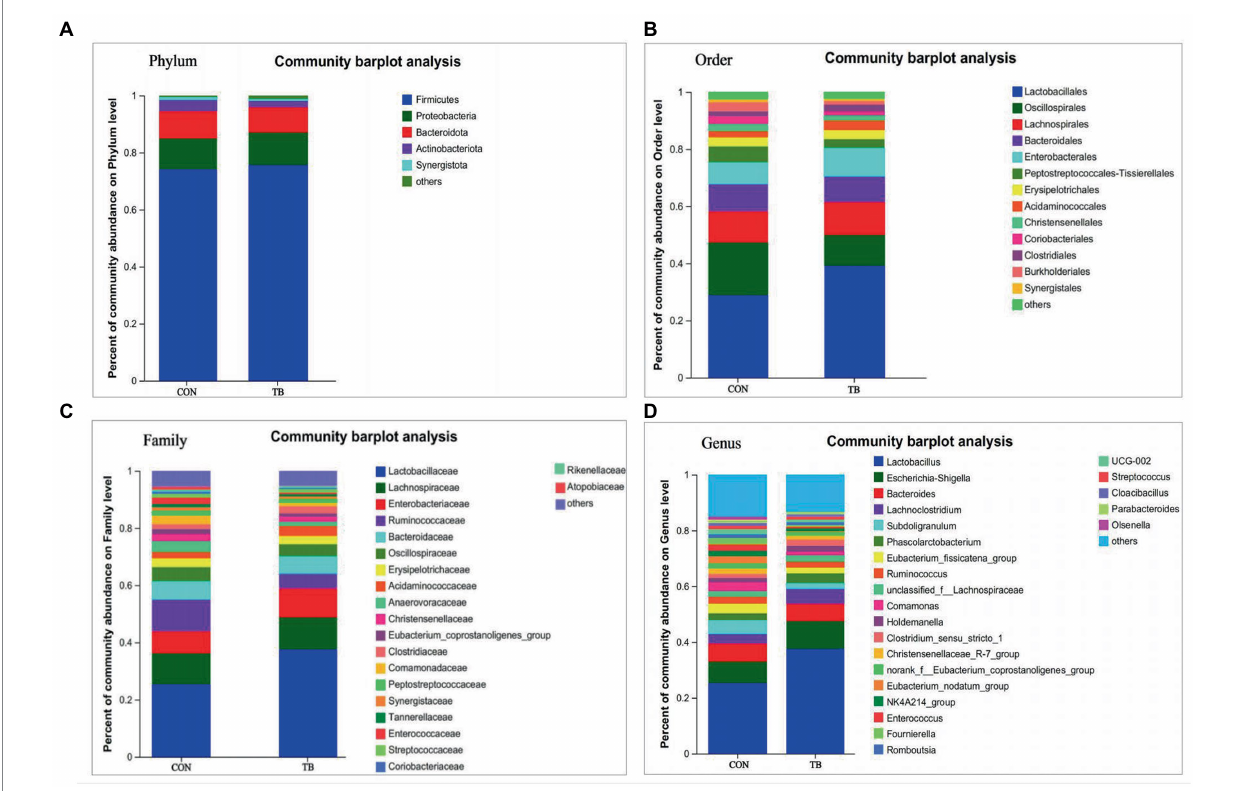
FIGURE 3 Effects of tributyrin on the fecal microbial composition of piglets. The overall composition of fecal microbial flora in piglets at phylum (A) , order (B) , family (C) , and genus (D) level is indicated in the bar charts. Each bar graph represents the average relative abundance of each bacterial taxon in a set. The abscissa/ordinate shows the sample name, the ordinate/abscissa shows the proportion of the species in the sample, columns of different colors represent different species, and the length of the columns represents the proportion of the